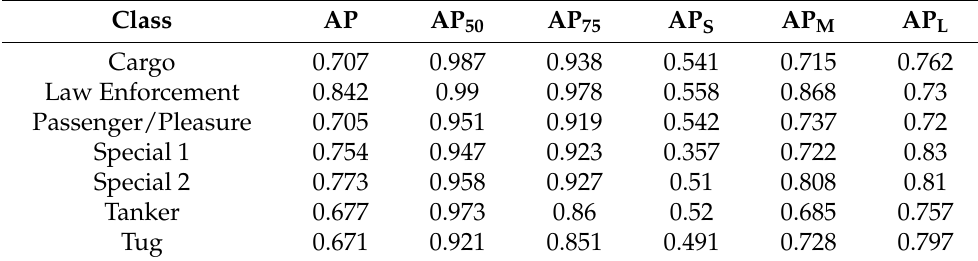
Table A1. Resulting instance segmentation APs per class of the ShipSG dataset using Mask-RCNN, as explained in Section 3.1.